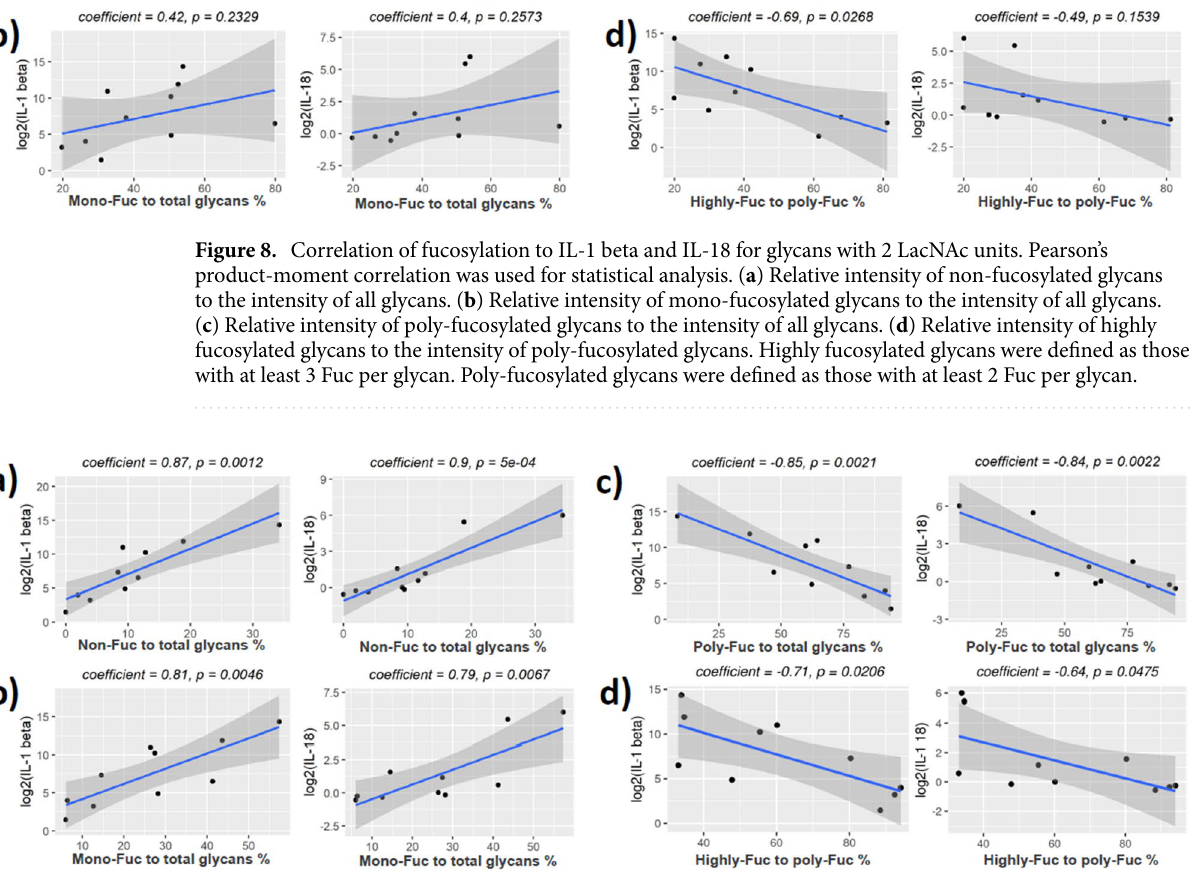
Figure 9. Correlation of fucosylation to IL-1 beta and IL-18 for glycans with 3 LacNAc units. Pearson’s product-moment correlation was used for statistical analysis. ( a ) Relative intensity of non-fucosylated glycans to the intensity of all glycans. ( b ) Relative intensity of mono-fucosylated glycans to the intensity of all glycans. ( c ) Relative intensity of poly-fucosylated glycans to the intensity of all glycans. ( d ) Relative intensity of highly fucosylated glycans to the intensity of poly-fucosylated glycans. Highly fucosylated glycans were defined as those with at least 4 Fuc per glycan. Poly-fucosylated glycans were defined as those with at least 2 Fuc per